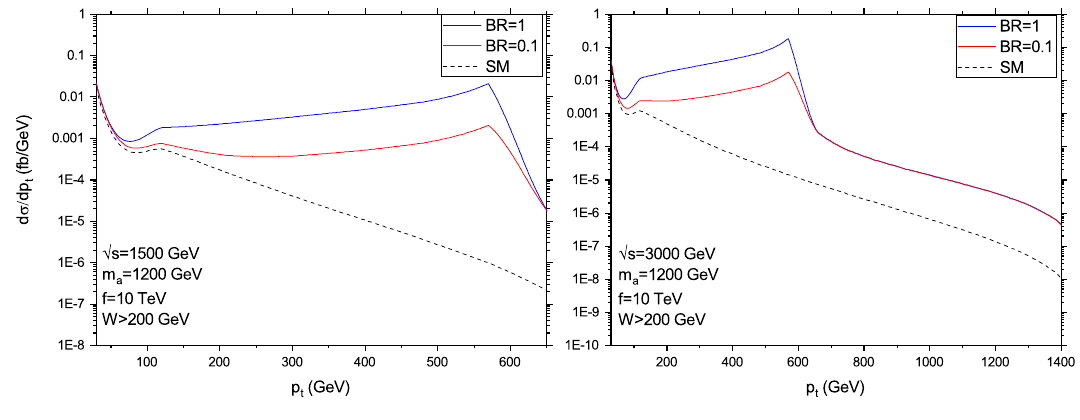
Figure 9 . The differential cross sections for the process e + e − e + γγe − e + a e − e + γγe − → → → at the CLIC in the WWA for the initial photons in the subprocess γγ γγ as functions of the → transverse momenta of the final photons p t for the ALP mass m a = 1200 GeV and coupling constant f = 10 TeV. The invariant energy is equal to √ s = 1500 (3000) GeV on the left (right) panel. The curves for both Br( a γγ ) = 1 . 0 and Br( a γγ ) = 0 . 1 are shown. The dashed lines denote → →